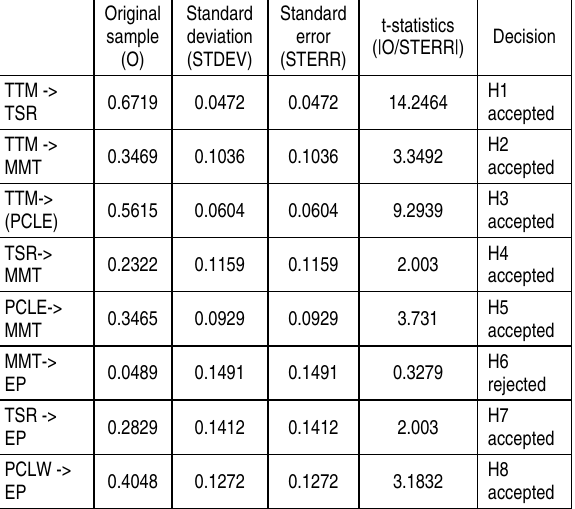
Table 2. The coefficient values, standard